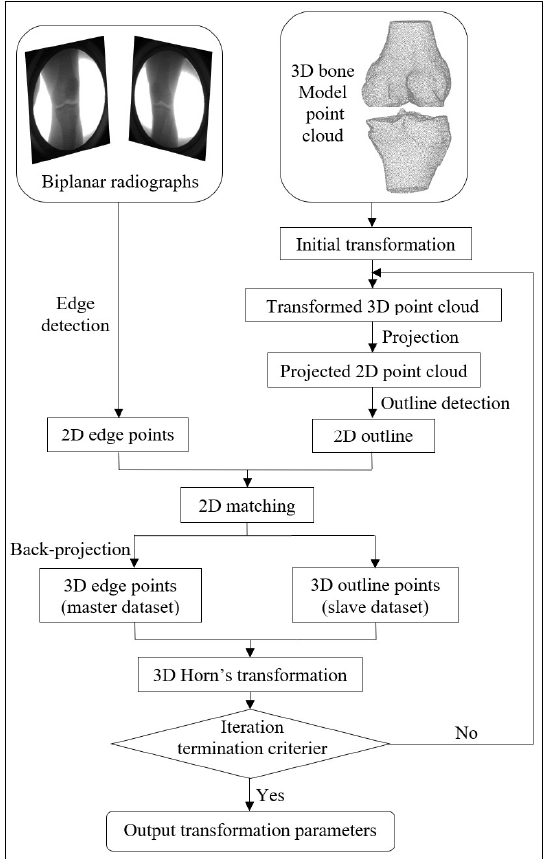
Figure 4. ICP-based 2D-3D registration flow chart.